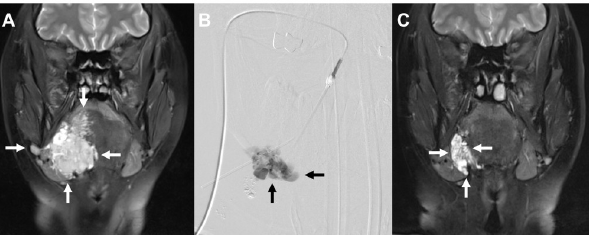
Fig 1. Illustration of an example case. This case demonstrates a 28-year-old female patient who suffered from pain and dysphagia, caused by a VM of the right-sided floor of mouth with involvement of the tongue. Pre-interventional T2w fat-saturated MRI shows the extent of the VM (white arrows in A). One percutaneous sclerotherapy session was performed under fluoroscopy guidance using 2 mL polidocanol 3% with foam. Intraprocedural digital subtraction angiography was performed to confirm the correct position of the needle (black arrows in B). In the MRI one year after the sclerotherapy (C) the size of the VM was significantly smaller (pre-interventional volume: 120.1 cm 3 , post- interventional volume: 65.4 cm 3 ) and the patient reported substantial symptom relief.